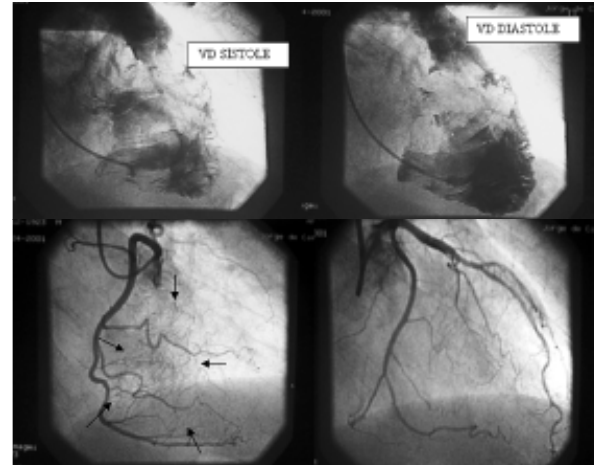
Fig. 6 - Cineangiocoronariografia. Notar a presença de grande falha de enchimento na cavidade ventricular direita (comparar imagens da sístole e diástole de VD), determinante de restrição importante ao enchimento diastólico de VD. Notar área de hipervascularização, com predomínio de vasos neoformados a partir da artéria coronária direita, para a irrigação do tumor